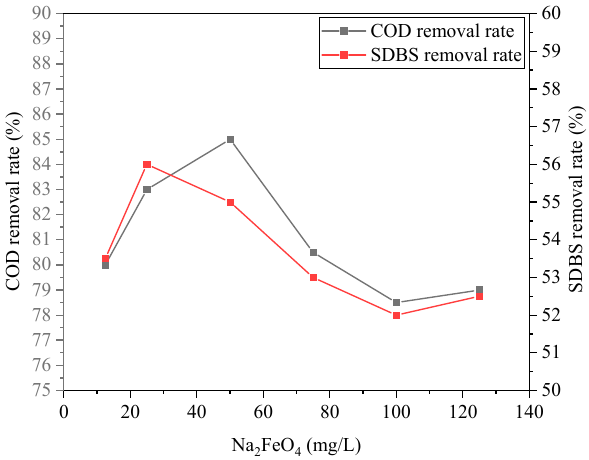
Figure 4. Effect of Na 2 FeO 4 dosage on removal rates of COD and SDBS.